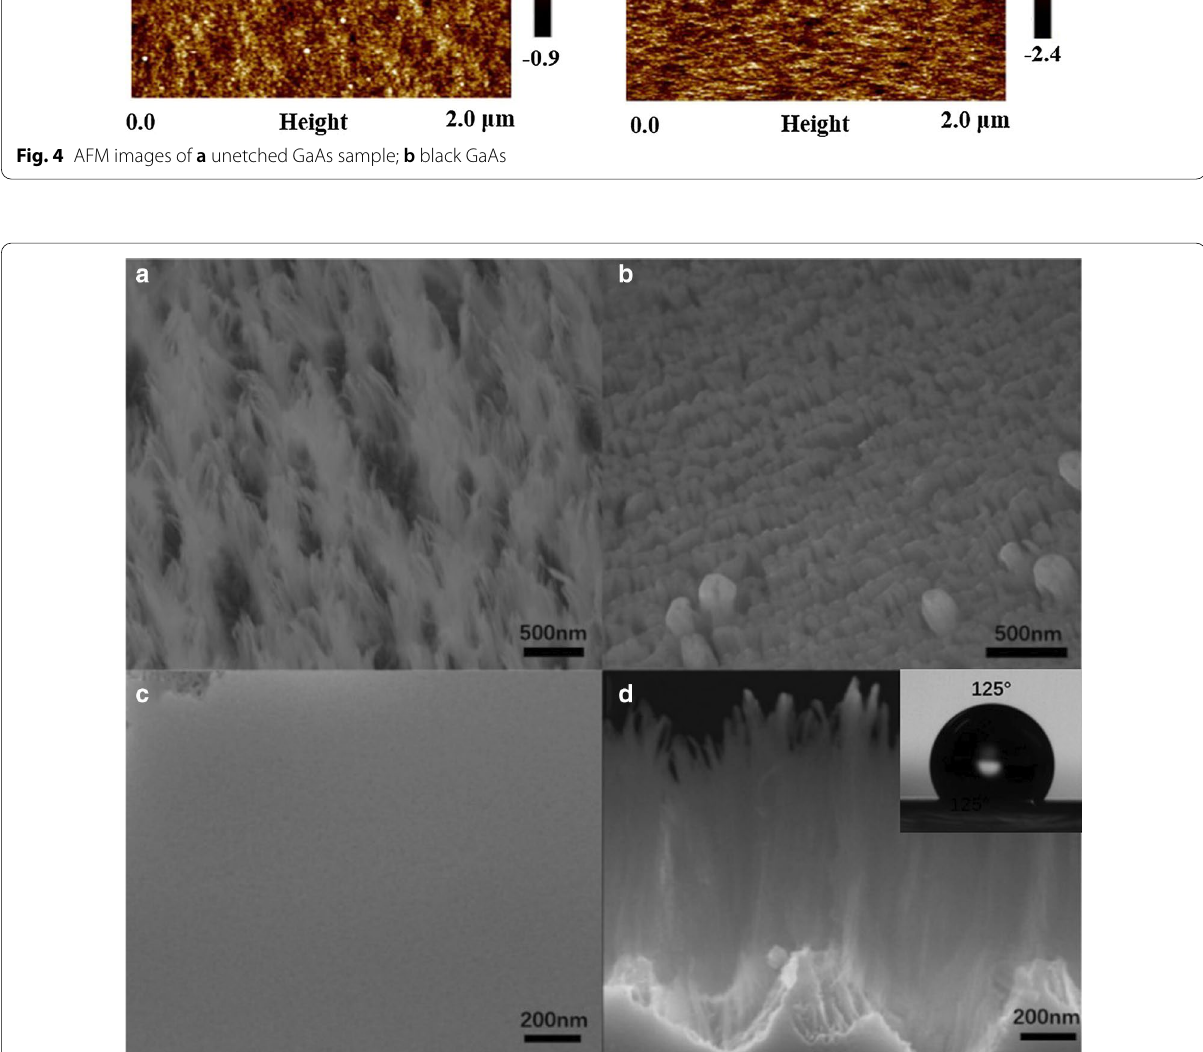
Fig. 5 a – c SEM images of GaAs substrate under different oxygen flow rate; d the cross-sectional SEM image of GaAs substrate under the oxygen flow rate of